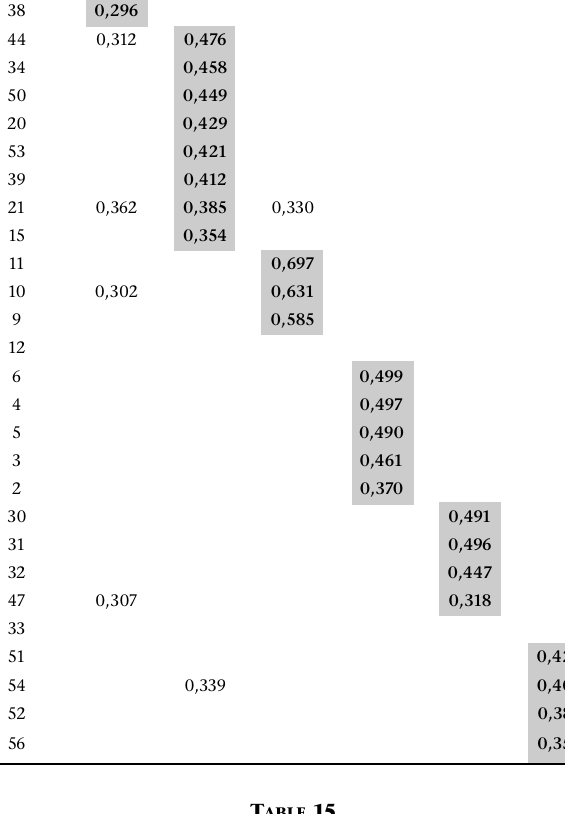
Table 18. The obtained single scale yielded a Cronbach Alpha of